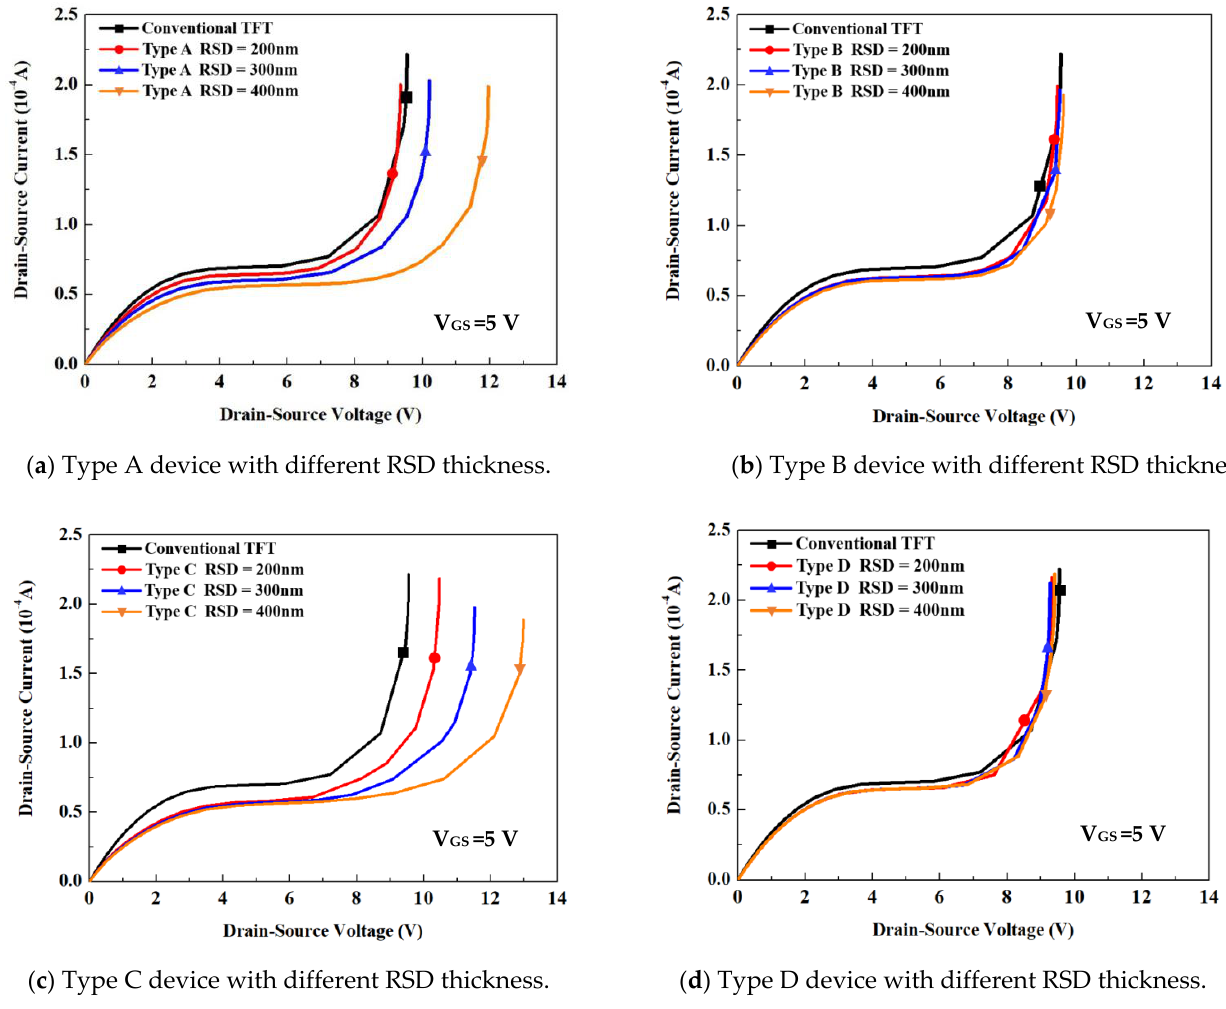
Figure 5. ( a - d ) The I DS - V DS characteristic curve comparison for all of the RSD structures. Figure 5. ( a – d ) The I DS -V DS characteristic curve comparison for all of the RSD